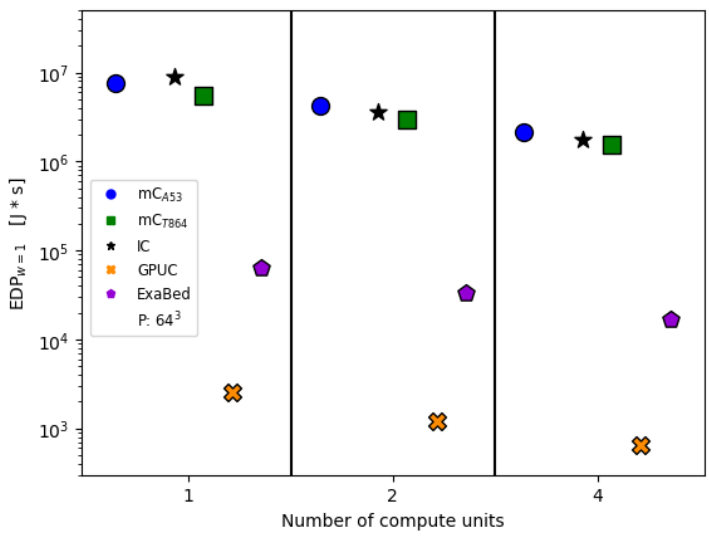
Figure 4. EDP as a function of the CUs using 64 3